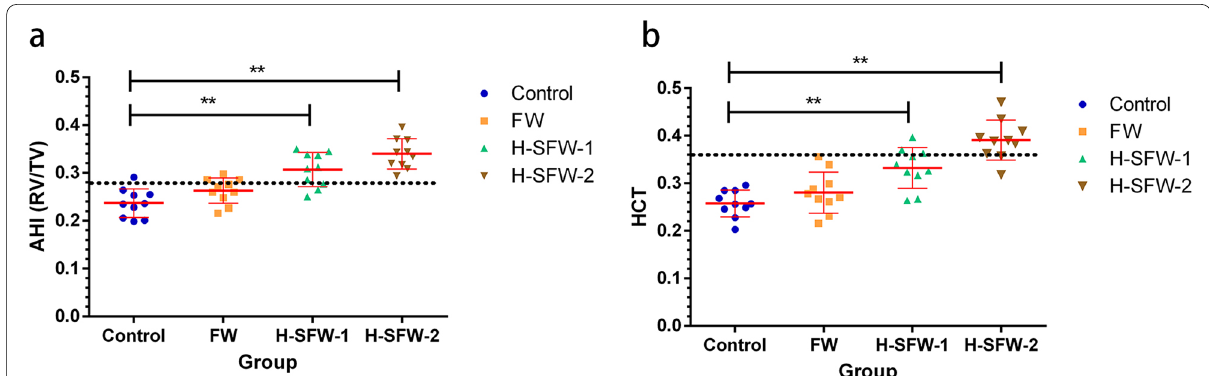
Fig. 1 Effects of different NaCl contents in drinking water on hematocrit (HCT) and ascites heart index (AHI) of broilers. They were randomly divided into four groups: a control group (deionized water, NaCl at 0 g/L), a freshwater group (FW, deionized water group 1 (H-SFW-1, deionized water NaCl at 2.5 g/L) and high salinized freshwater group 2 (H-SFW-2, deionized water + TV, right ventricular weight/total ventricular weight) of broilers in control group, FW group, H-SFW-1 group and H-SFW-2 group. ( n